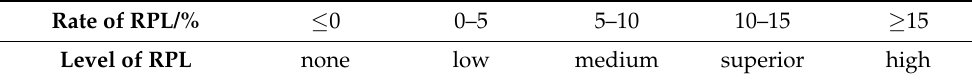
Table 1. Criteria for determining the level of RPL. Rate of RPL/% ≤